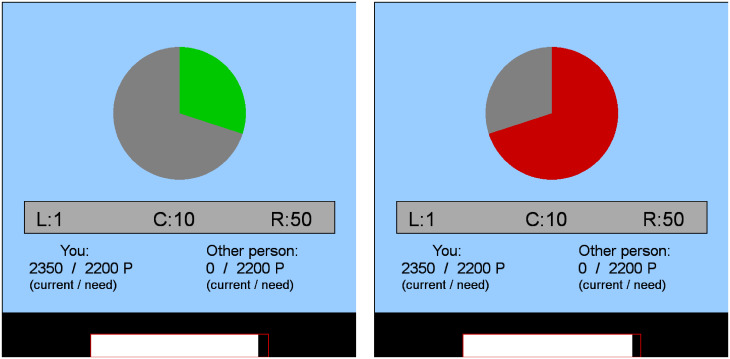
Screenshots of the display.Need game embedded in a lottery frame either as gain (left) or as loss (right). The probability of winning/losing the bet is presented in a pie chart. In a gain trial, the probability of winning is marked in green and the probability of losing in gray. In a loss trial, the probability of winning is marked in gray and the probability of losing in red. Below the pie charts are the number of points displayed from which the donor can bet on: 1, 10, or 50 points. L, C, and R in front of the bets refer to the keys the participant needs to press to indicate her/his choice. The third row in the display shows the current endowment and need of the donor (“you”) and that of the recipient (“Other person”). The last row indicates the remaining time allotted to a given trial.